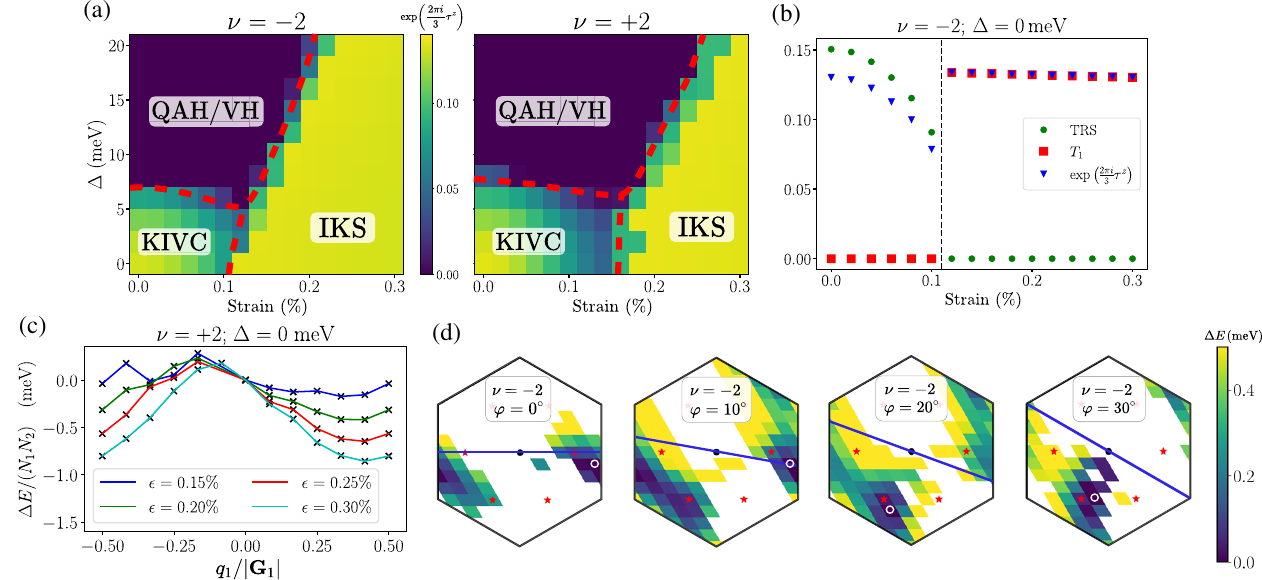
FIG. 3. (a) ν ¼ (cid:2) 2 strain-substrate HF phase diagram (enlarged view of panels from Fig. 2). Strain is along the x axis ( φ ¼ 0 °), and translational symmetry breaking is restricted to q ¼ G 1 = 3 . The color plot diagnoses IVC order by taking the Frobenius norm of the difference of the density matrix after acting with e ð 2 π i= 3 Þ τ z . Dashed red lines indicate approximate phase boundaries. Particle-hole breaking is introduced via nonlocal tunneling (NLT). System size is 12 × 12 , and only central bands are active. (b) Phase transition between KIVC and IKS states along the strain axis of (a) at ν ¼ − 2 . In the IKS phase, combined U V ð 1 Þ rotation by 2 π = 3 and real-space translation by a 1 is a symmetry. (c) IKS energy relative to the lowest translation-symmetric state for different strains and spiral wave vectors q along G 1 . NLT is not included. (d) Relative energies of IKS states for different strain angles φ (blue axis) and enforced symmetry-breaking wave vectors q [see Eq. (2)]. Red stars denote q ’ s corresponding to period tripling along the moir´e axes, and white circles denote minimum energy wave vectors q 0 . Non-IKS states that converge to higher energies are discarded. Strain is 0.2%, and NLT is not included. Data points are transformed to fit on a hexagonal